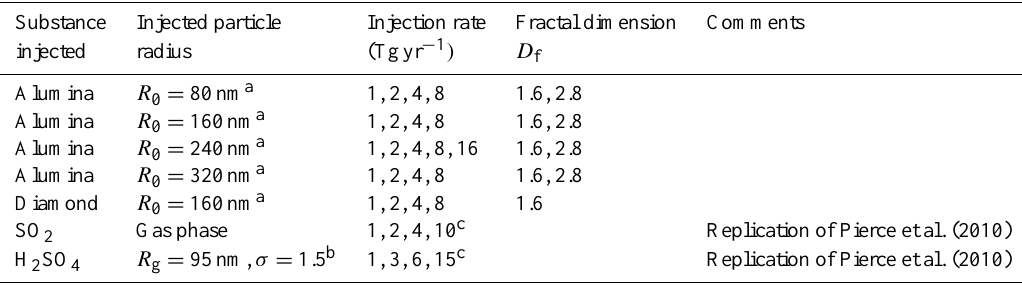
Table 1. Overview of experiments performed with the AER 2-D model. Substance Injected particle Injection rate Fractal dimension Comments injected radius (Tgyr − 1 ) D f Alumina R 0 = 80nm a 1, 2, 4, 8 1.6, 2.8 Alumina R 0 = 160nm a 1, 2, 4, 8 1.6, 2.8 Alumina R 0 = 240nm a 1, 2, 4, 8, 16 1.6, 2.8 R 0 = 320nm a 1, 2, 4, 8 1.6, 2.8 Diamond R 0 = 160nm a 1, 2, 4, 8 SO 2 Gas phase 1, 2, 4, 10